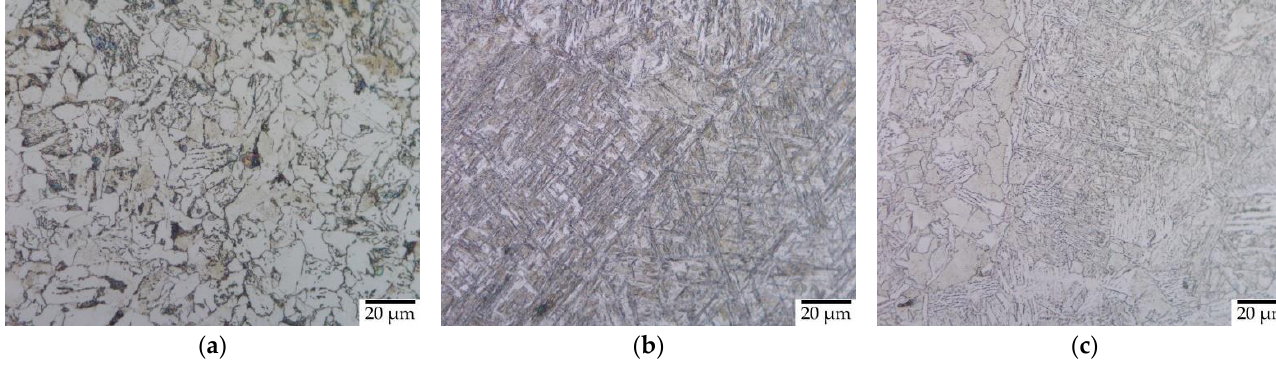
Table 3. Hardness test results for original, quenched, and tempered samples for heat-treatment pro- Figure 5. Microstructure of ( a ) original (O), ( b ) quenched (Q), and ( c ) tempered (T) samples by cedures. HT2.